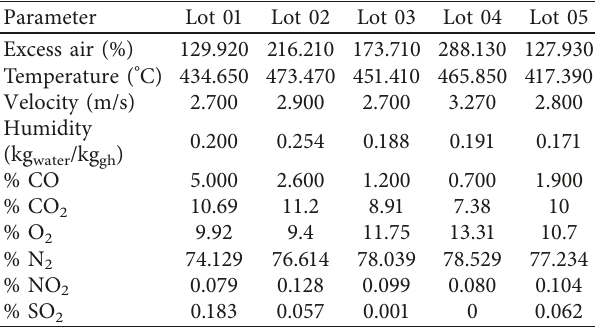
Table 3: Results of the isokinetic testing for chimney